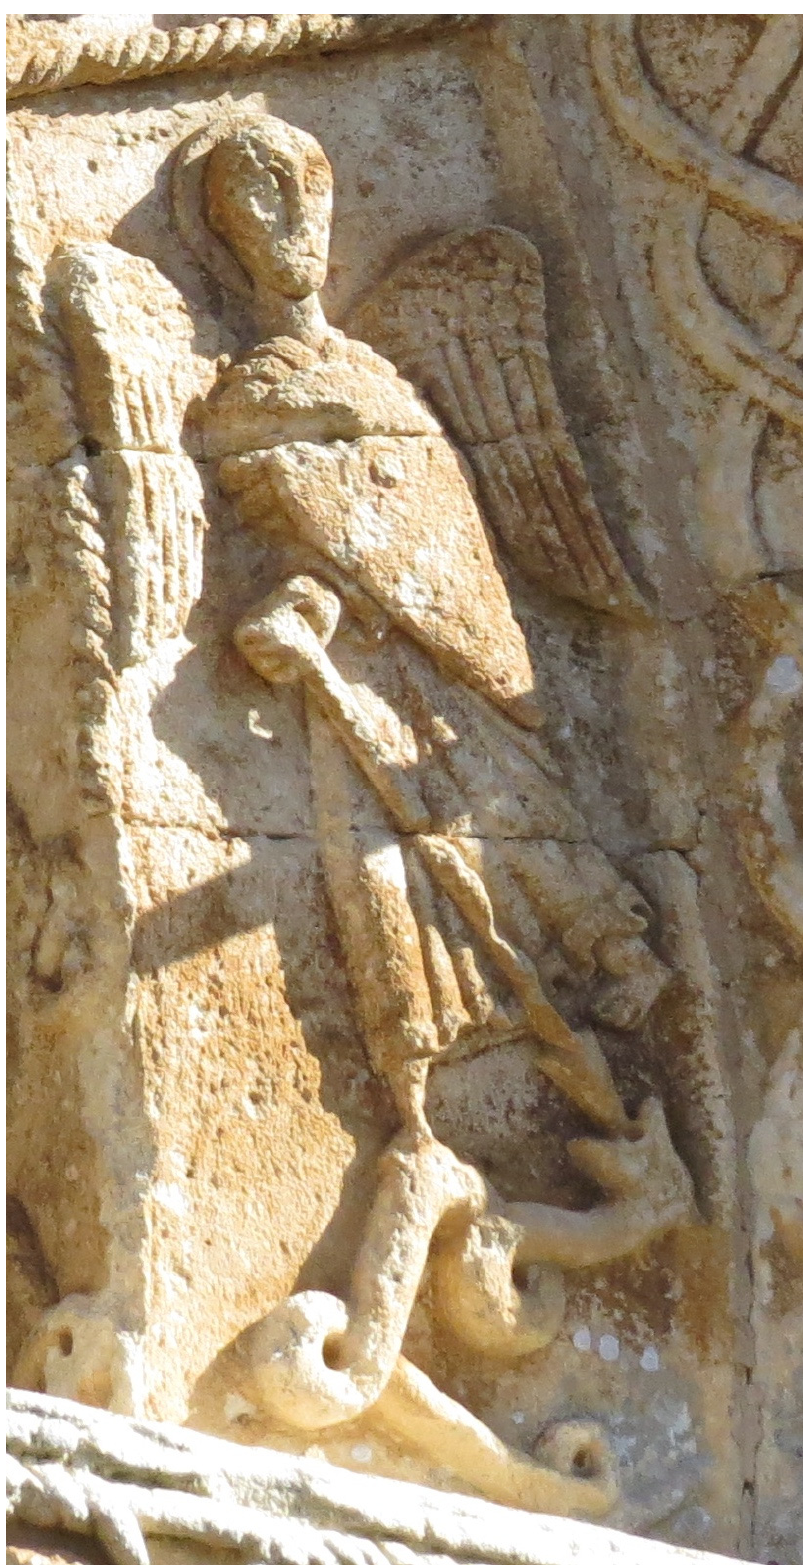
Figure 9. Saint Michael the Archangel defeating the dragon, detail of archivolt, west façade, Saint-